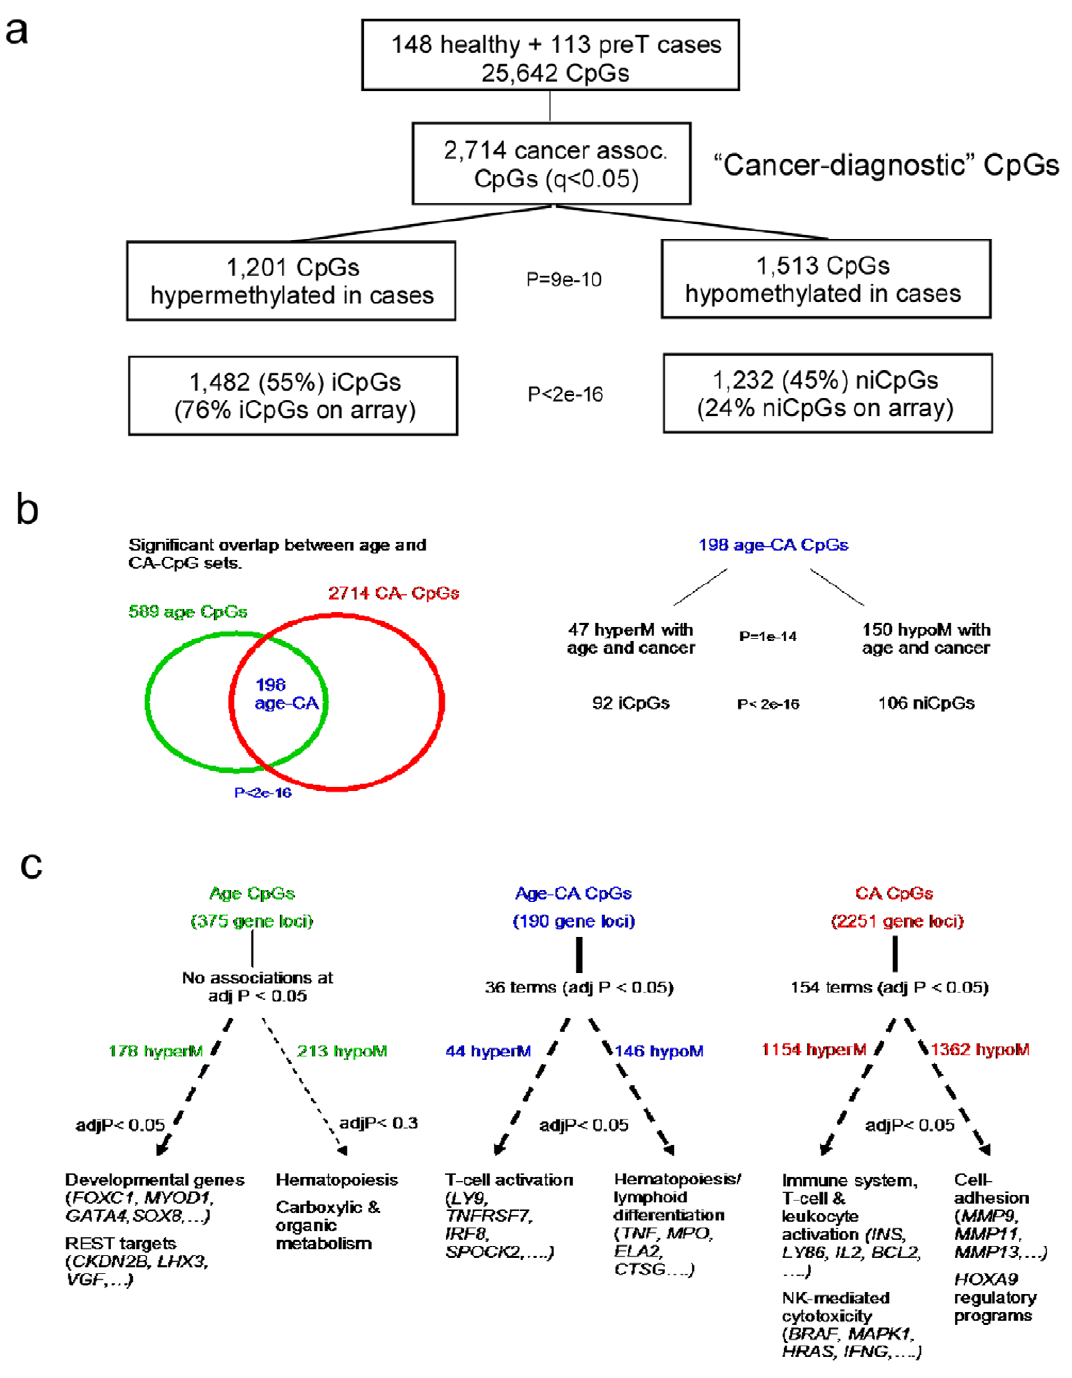
Figure 2. Cancer and age CpGs, and GSEA. a ) Distribution of 2,714 CA-CpGs (FDR , 0.05) in terms of hyper-and-hypomethylation (Binomial test P-value given), as well in relation to CpG localisation (Fisher’s exact test). b ) Overlap of age-CpGs with CA-CpGs (Fisher-test P-value of overlap given) and distribution of the 198 common age and CA-CpGs in terms of hypermethylated and hypomethylated patterns and iCpGs/niCpGs (Binomial and Fisher-test P-values are given, respectively). Out of the 198 CpGs, 47 exbited hypermethylation with age and cancer, 150 hypomethylation with age and cancer, 1 hyperM with age and hypoM with cancer and 0 showed hypoM with age and hypeM in cancer. c ) Gene Set Enrichment Analysis for the common age CA-CpGs, age-specific CpGs (i.e age CpGs minus CA-CpGs) and CA-specific CpGs (i.e CA-CpGs minus age-CpGs) stratified according to hyper/hypometylation. Benjamini-Hochberg adjusted P-values are given. Most significantly enriched biological terms are given.